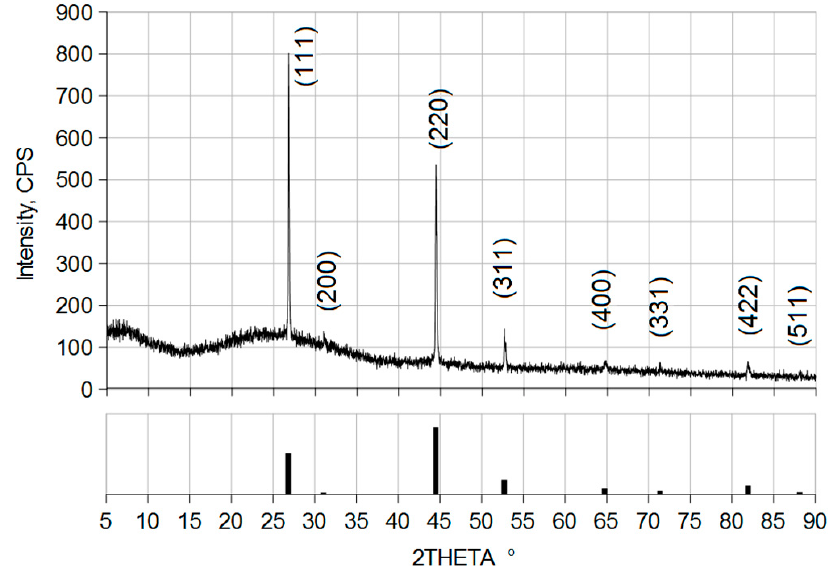
Figure 2. XRD pattern of the film in the initial state. The bottom of the plot shows the details of the ICDD card 01-075-2714 for С u 1.75 Se.